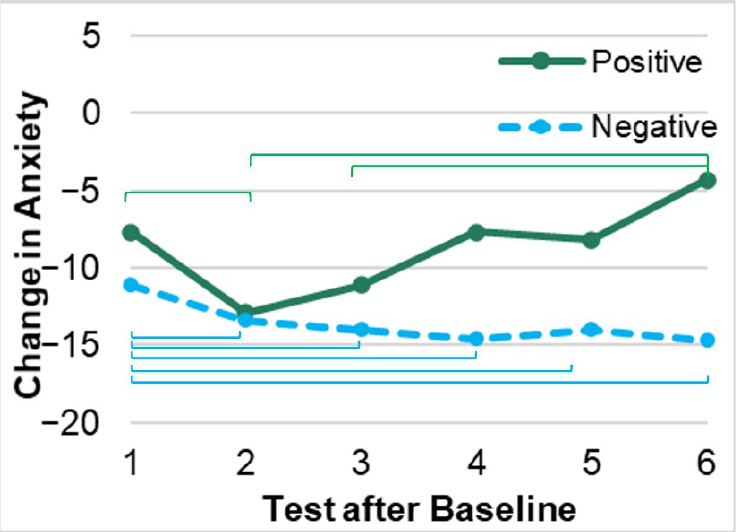
Figure 1. Changes in anxiety with the test results. Note: brackets indicate significant differences ( p < 0.05) within each group.